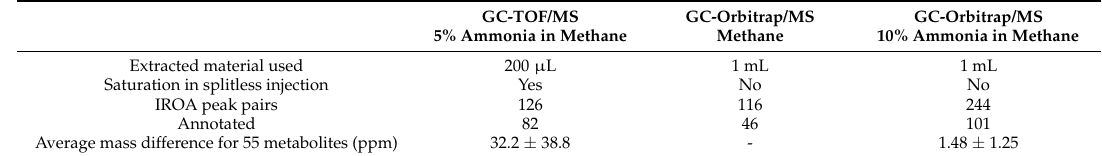
Table 1. Overall comparison between IROA results obtained from GC-Orbitrap and GC-TOF/MS, with different CI reagent gases. The GC-Orbitrap allows more material to be injected due to wider dynamic range, which results in the detection of more IROA pairs. Pure methane as reagent gas produces more fragments than using an ammonia/methane mixture, and pure CI methane will lower the intensity of the molecular ion, resulting in less IROA metabolites detected. GC-TOF/MS used 5% ammonia in methane as the reagent gas, and GC-Orbitrap/MS used 10% ammonia in methane as the reagent